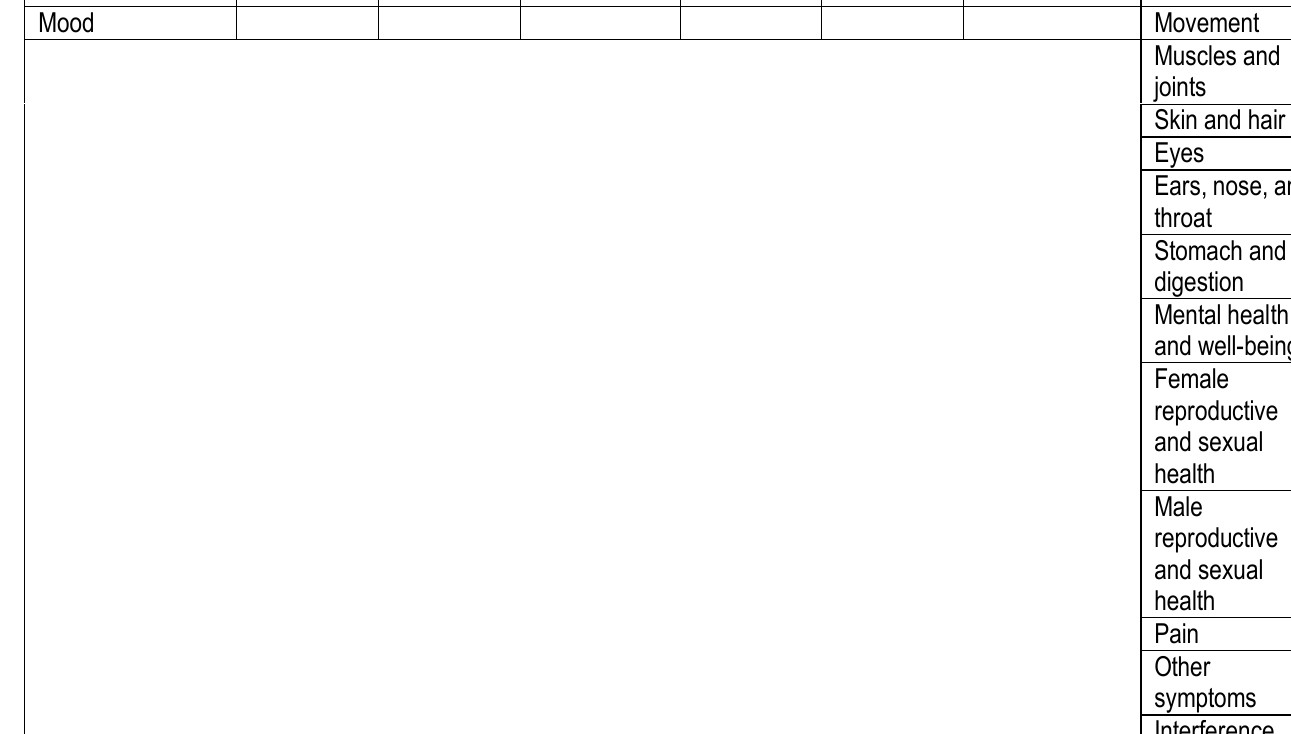
Table 1. Prior studies: Researchers, Year, Method, Sample size, and Domains Guo et al. [24] PCA 6